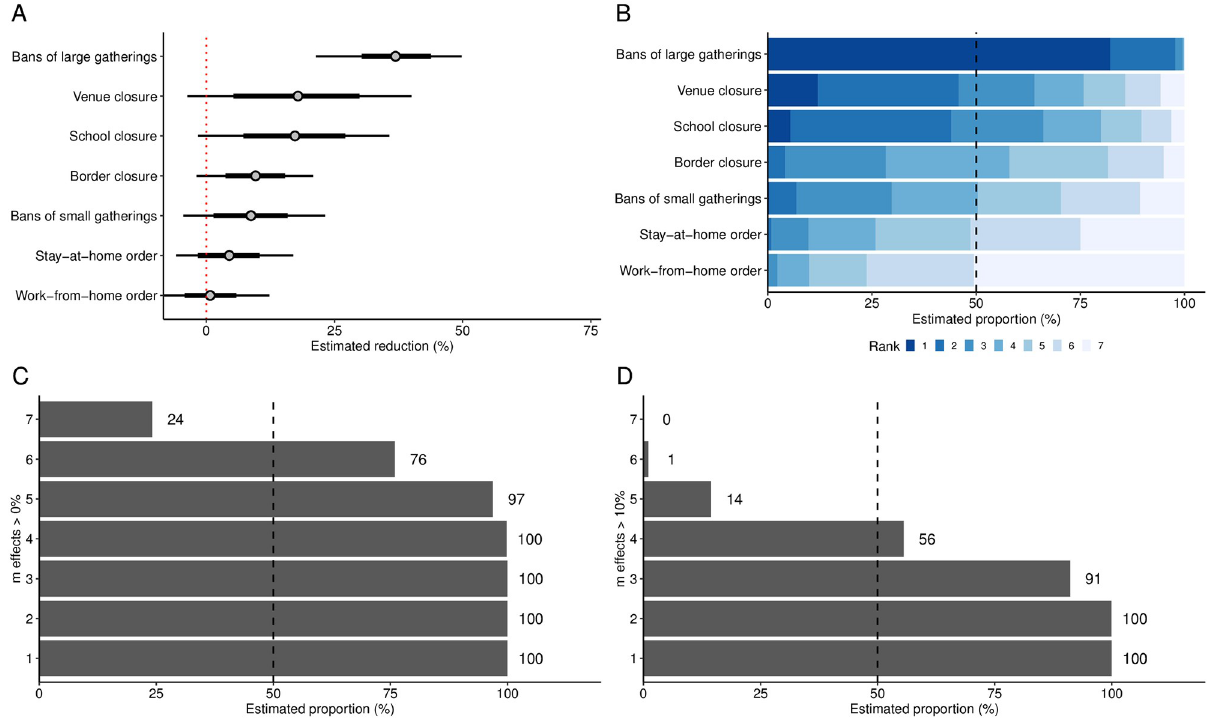
Fig 4. Estimated effects of NPIs. (A) Reduction in new infections (posterior mean as dots with 80% and 95% credible interval as thick and thin lines, respectively). (B) Ranking of the effects of NPIs from highest (1) to lowest (7) (posterior frequency distribution). (C) Frequency of at least m positive effects (posterior frequency distribution). (D) Frequency of at least m effects greater than 10% (posterior frequency distribution).